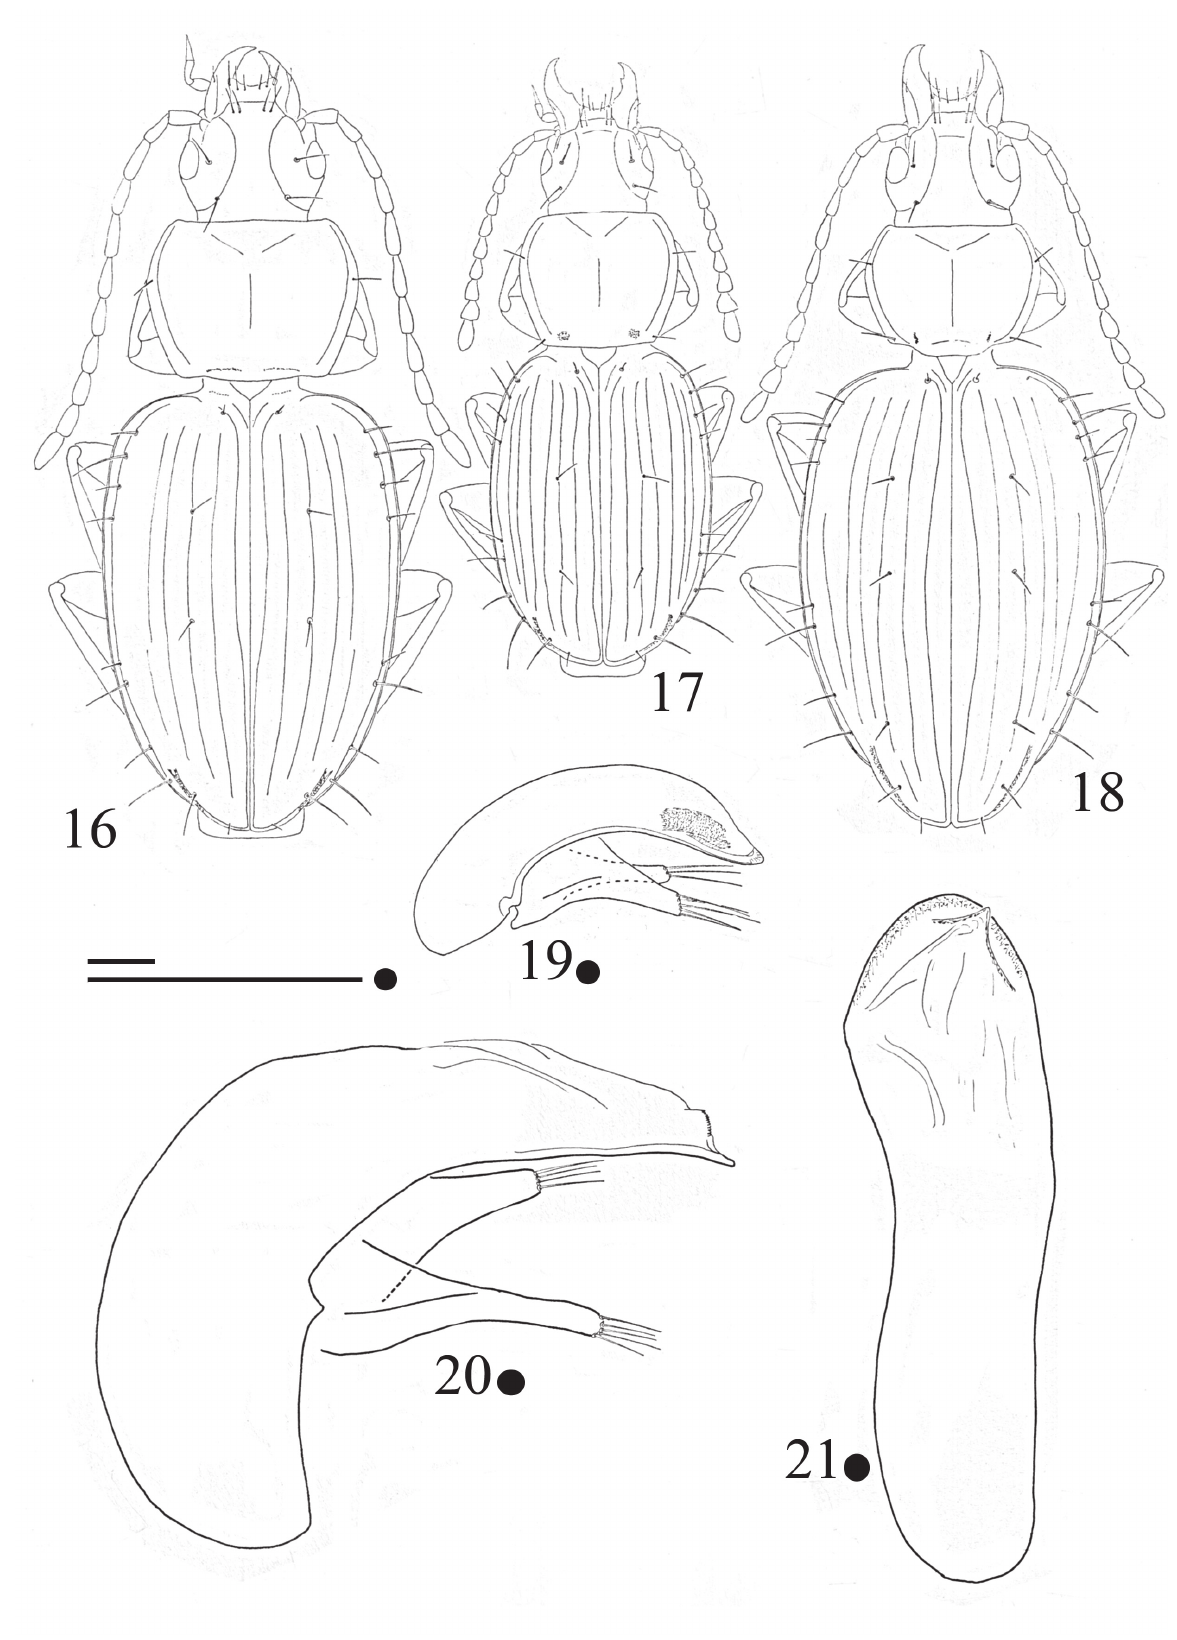
Figs 16-21. Habitus (16, 17, 18), aedeagus in lateral view (19, 20) and aedeagus in dorsal view (21) of Tasmanorites spp.: 16, 19) T. grossus Moore, ♂ from Lake Osborne; 17) T. madidus Moore, ♀ from Creepy Crawly Walk; 18, 20, 21) T. riparius Moore, ♂ from Murchison State Forest. Scale: 0.5